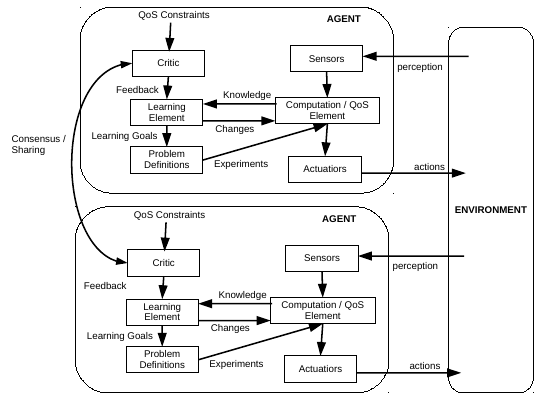
Figure 1. Agents interacting with the